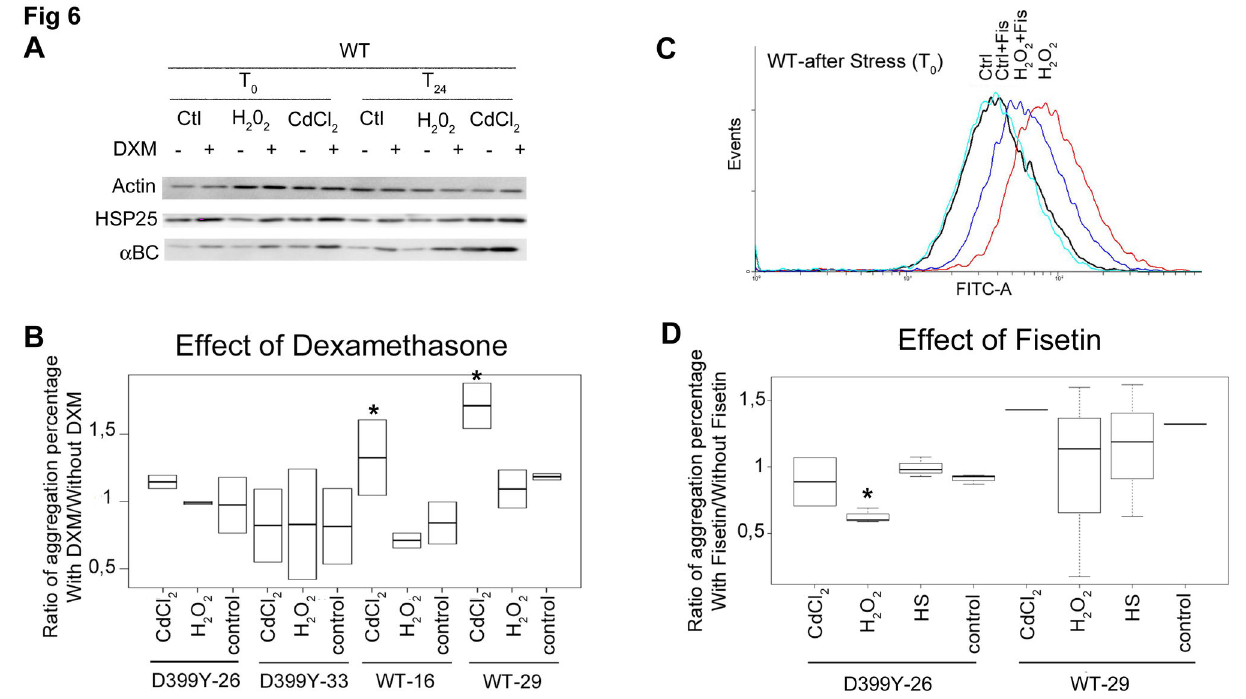
Figure 6. Effect of putative anti-aggregative molecules for reducing stress in our cell model. ( A ) Western blot quantification of sHSP and actin in our various cell lines, unstressed (control) and stressed (H Equal amounts of proteins probed with anti-alpha-actin antibody to normalize protein levels.